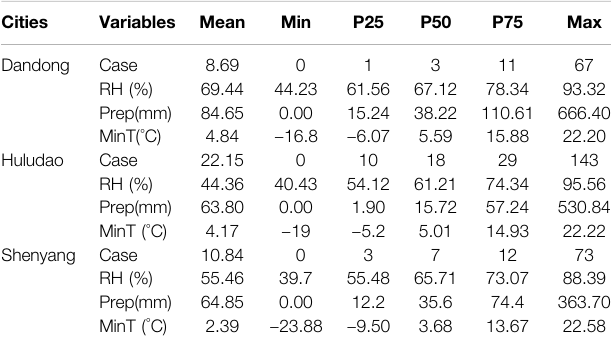
TABLE 1 | Monthly meteorological variables and HFRS occurrence in the three cities from 2005 to